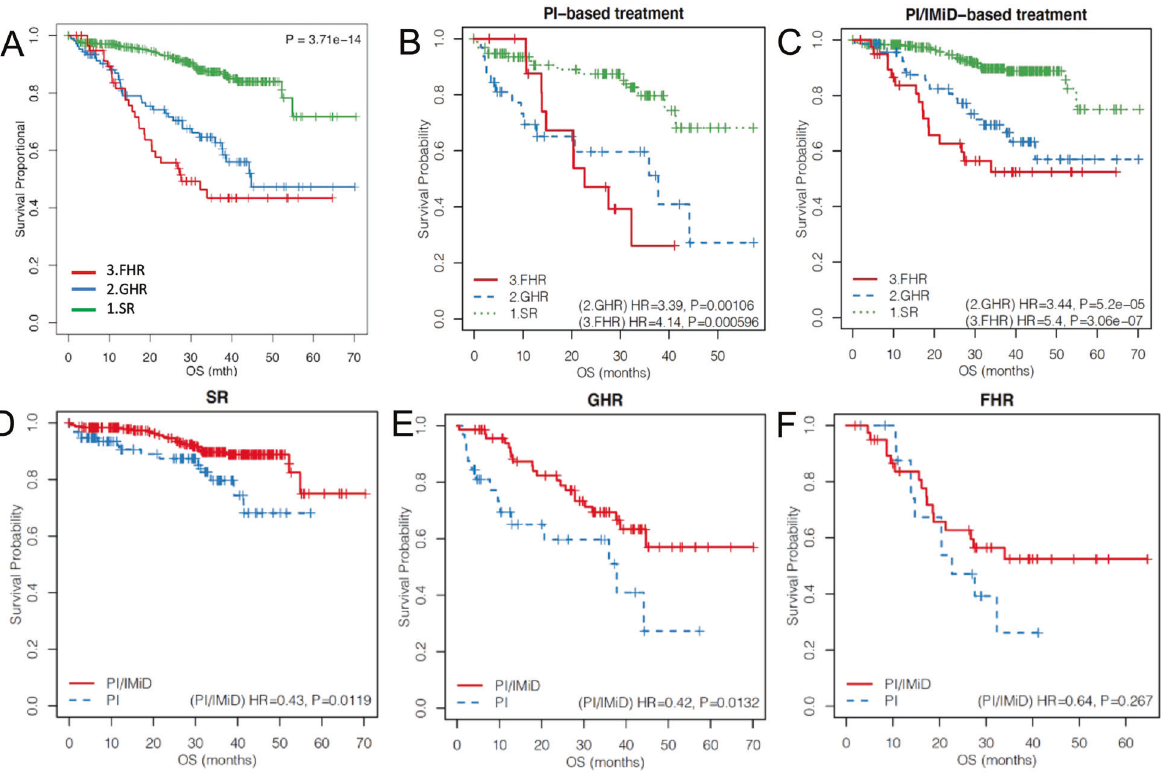
Fig. 1 Survival curves for FHR, GHR, and SR MM patients in CoMMpass dataset. A Overall ( B ) FPI-based induction treatment and ( C ) PI/IMiD- based induction treatment. Survival curves for patients treated with PI and PI/IMiD in ( D ) SR, ( E ) GHR, ( F ) FHR groups, respectively. P -values indicate Cox regression test of PI/IMiD treatment against PI